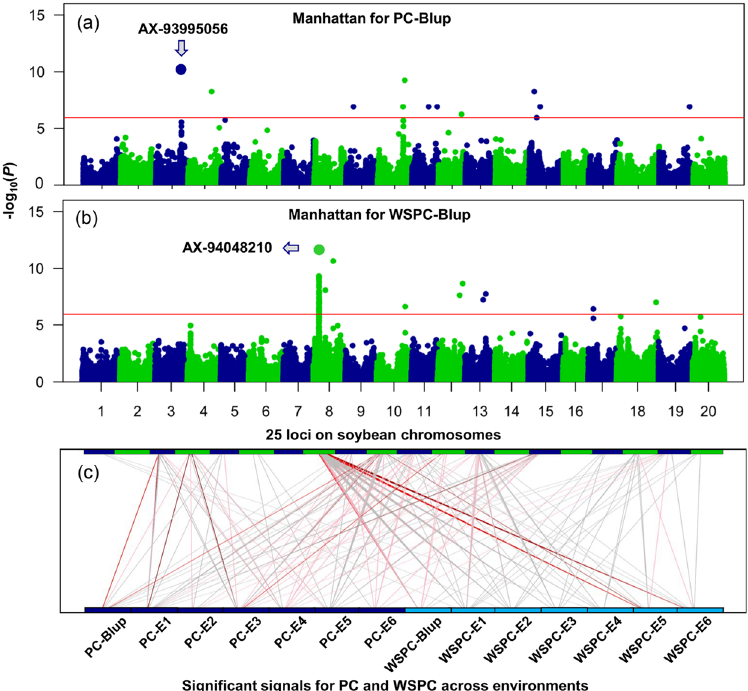
Figure 2. Genetic architecture of soybean protein content (PC) and water-soluble protein content (WSPC). ( a ) and ( b ) Manhattan plot for the BLUP of soybean PC and WSPC across six environments by genome- wide association mapping. Red horizontal lines depict the Bonferroni-adjusted significance threshold ( P < 4.95 × 10 − 6 ). The x axis shows the 20 soybean chromosomes, and the y axis shows the significance expressed as − log 10 P value. ( c ) Associations between 25 loci aligned on the upper boundary and 14 phenotype values (contain two traits across six environments and their BLUP) aligned on the lower boundary. Positions of loci correspond to the above panel. Deep red, red, pink, and gray lines represent significant associations between SNPs and phenotype value with threshold levels of P < 1.0 × 10 − 11 , P < 1.0 × 10 − 9 , P < 1.0 × 10 − 7 , P < 1.0 × 10 − 5 ,